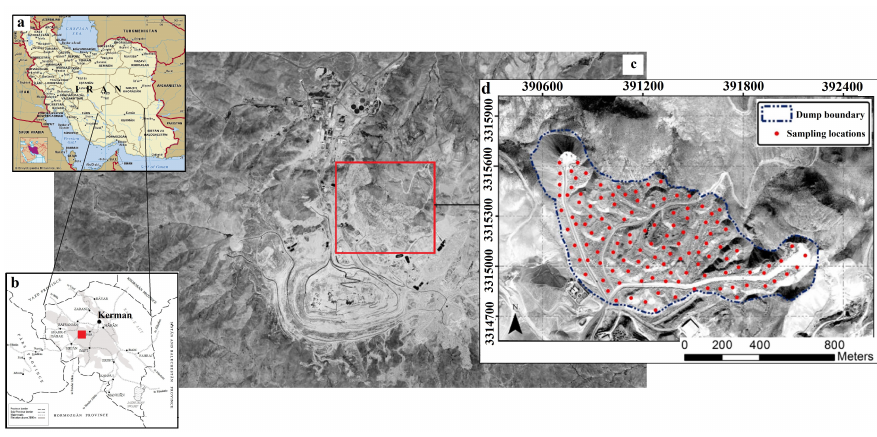
Figure 1. Study area in Iran ( a ), in Kerman province ( b ), in Sarcheshmeh copper complex ( c ) and dump number 31 ( d